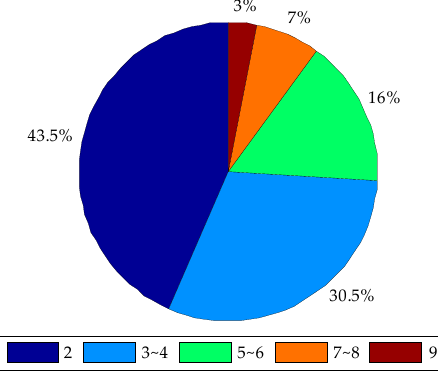
Figure 3. The probability of daily trips per vehicle.